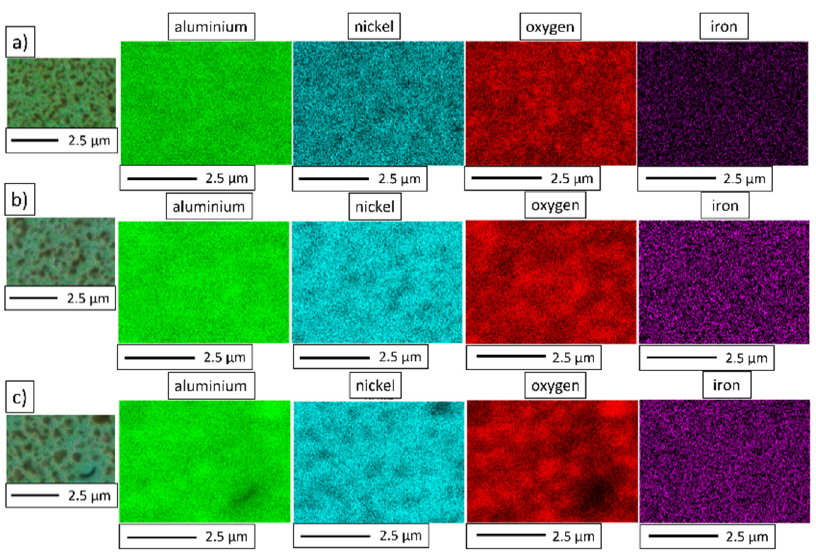
Figure 14. The NiAl-20%Al 2 O 3 samples’ elemental distribution maps after sintering by PPS at different temperatures: ( a ) 1200 °C; ( b ) 1300 °C; ( c ) 1400 °C.